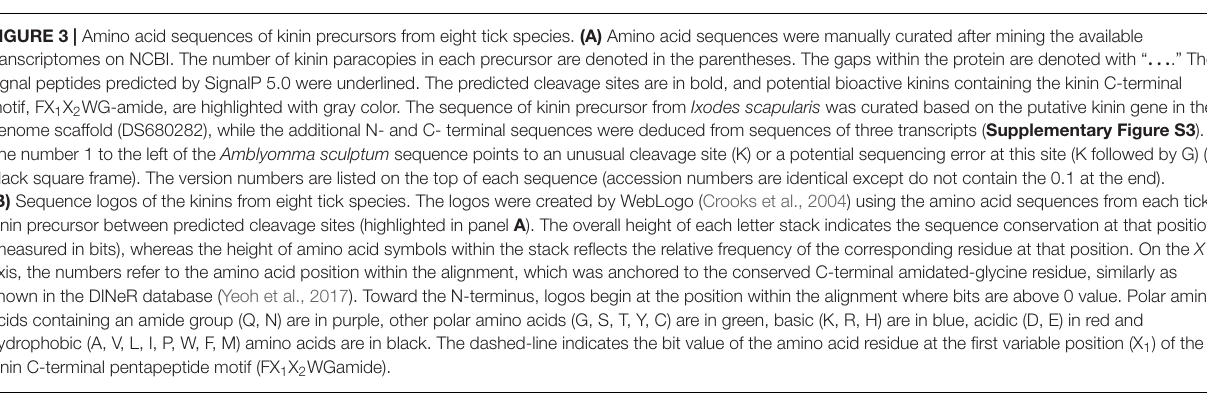
FIGURE 3 | Amino acid sequences of kinin precursors from eight tick species. (A) Amino acid sequences were manually curated after mining the available transcriptomes on NCBI. The number of kinin paracopies in each precursor are denoted in the parentheses. The gaps within the protein are denoted with “ ... .” The signal peptides predicted by SignalP 5.0 were underlined. The predicted cleavage sites are in bold, and potential bioactive kinins containing the kinin C-terminal motif, FX 1 X 2 WG-amide, are highlighted with gray color. The sequence of kinin precursor from Ixodes scapularis was curated based on the putative kinin gene in the genome scaffold (DS680282), while the additional N- and C- terminal sequences were deduced from sequences of three transcripts ( Supplementary Figure S3 ). The number 1 to the left of the Amblyomma sculptum sequence points to an unusual cleavage site (K) or a potential sequencing error at this site (K followed by G) (in black square frame). The version numbers are listed on the top of each sequence (accession numbers are identical except do not contain the 0.1 at the end). (B) Sequence logos of the kinins from eight tick species. The logos were created by WebLogo (Crooks et al., 2004) using the amino acid sequences from each tick kinin precursor between predicted cleavage sites (highlighted in panel A ). The overall height of each letter stack indicates the sequence conservation at that position (measured in bits), whereas the height of amino acid symbols within the stack reflects the relative frequency of the corresponding residue at that position. On the X axis, the numbers refer to the amino acid position within the alignment, which was anchored to the conserved C-terminal amidated-glycine residue, similarly as shown in the DINeR database (Yeoh et al., 2017). Toward the N-terminus, logos begin at the position within the alignment where bits are above 0 value. Polar amino acids containing an amide group (Q, N) are in purple, other polar amino acids (G, S, T, Y, C) are in green, basic (K, R, H) are in blue, acidic (D, E) in red